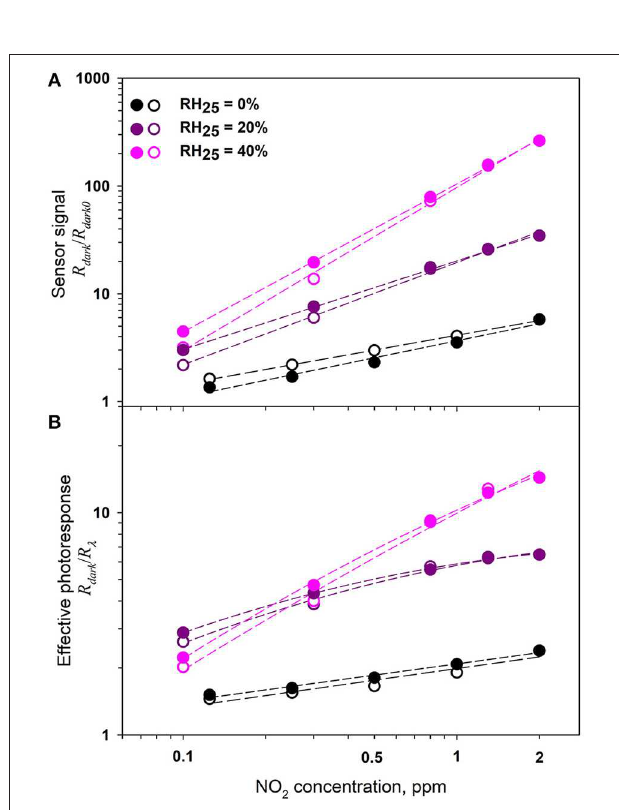
FIGURE 12 | Sensor signal S = R dark / R dark0 (A) and effective photoresponse P eff = R dark / R λ (B) of ZnO/CdSe nanocomposite under periodic green light illumination ( λ max = 535nm) with increasing (open symbols) and decreasing (filled symbols) NO 2 concentration in the gas phase at different